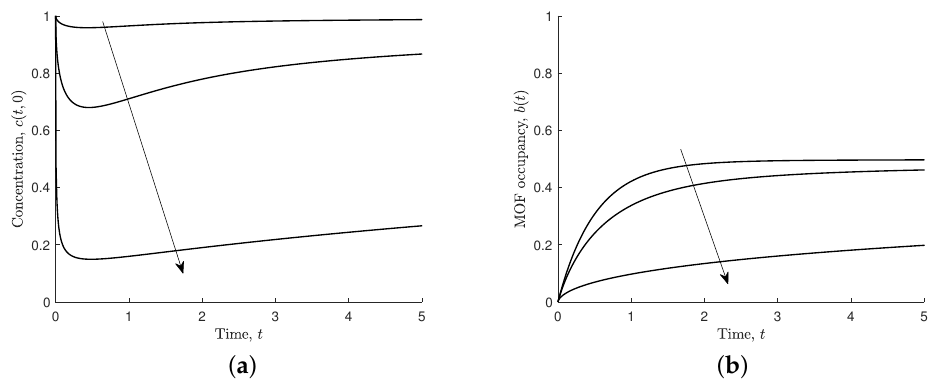
Figure 8. Results for different values of effective flux, s 4 = 0.1,1,10, and s 1 = s 2 = s 3 = 1. Arrows indicate the direction of increasing s 4 . ( a ) Non-dimensional concentration of ferric ions at MOF–polymer boundary, c ( t ,0 ) . ( b ) Non-dimensional MOF occupancy, b ( t )